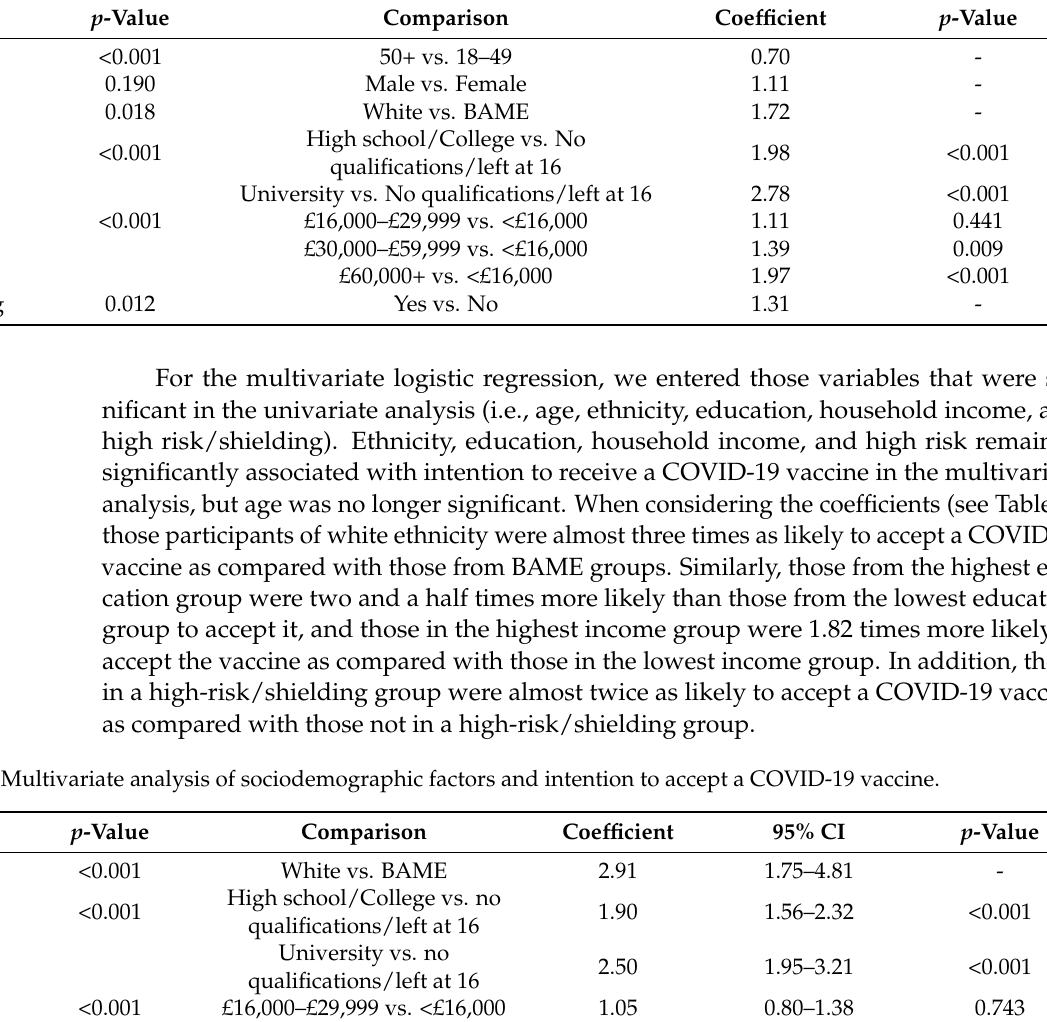
Table 3. Univariate analysis of sociodemographic factors and intention to accept a COVID-19 vaccine. Variable